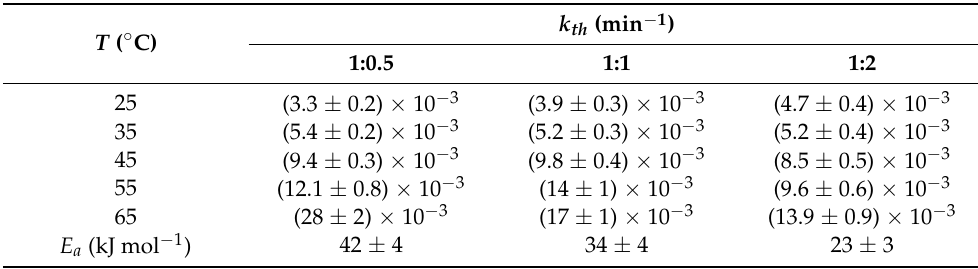
Figure 3. XRD patterns for PEG400: α -CD reaction (1:0.5 feed) at 50 °C as a function of time.